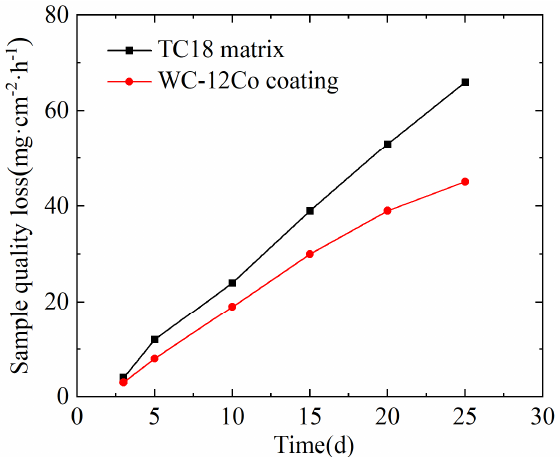
Figure 20. The change in corrosion weight loss of the substrate and the coating in artificial seawater with time. Table 9. The corrosion test results in artificial seawater.